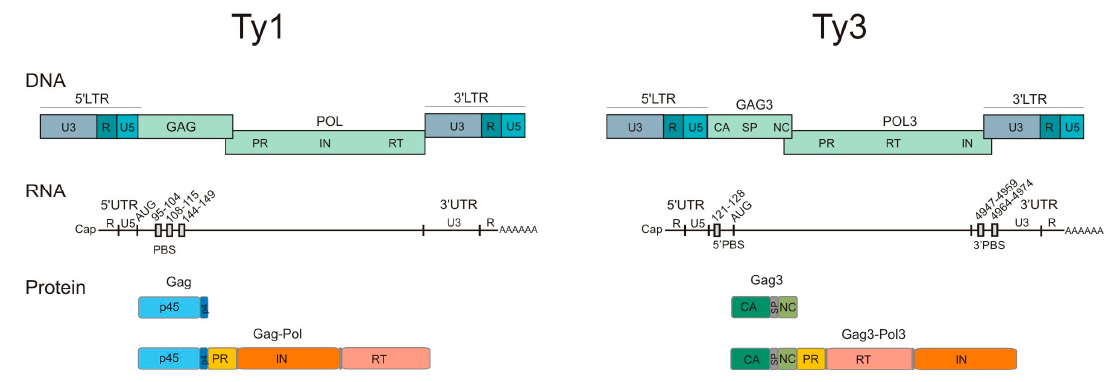
Figure 1. Structure of the Ty1 and Ty3 elements, RNAs, and proteins. Both elements contain long terminal repeats (LTRs) and central coding region with two overlapping ORFs: GAG and POL . The capped and polyadenylated genomic RNA contains untranslated regions (UTRs) and a primer binding site (PBS) that binds initiator tRNAiMet. GAG and POL encode Gag and Gag ‐ Pol. Gag ‐ Pol polyprotein contains enzymatic proteins: protease (PR), reverse transcriptase (RT), and integrase (IN). Ty1 Gag is post ‐ translationally cleaved into Gag p45 and short peptide p4, while Ty3 Gag3 is cleaved to capsid (CA), short spacer (SP), and nucleocapsid (NC).